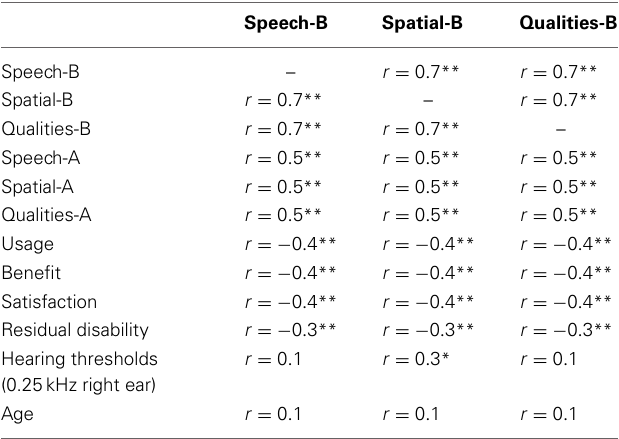
Table 4 | Results of pearson correlation for SSQ-B 3-month